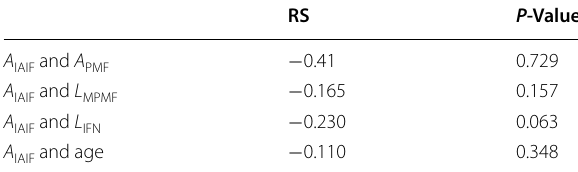
Table 5 Spearman correlation analysis for area of